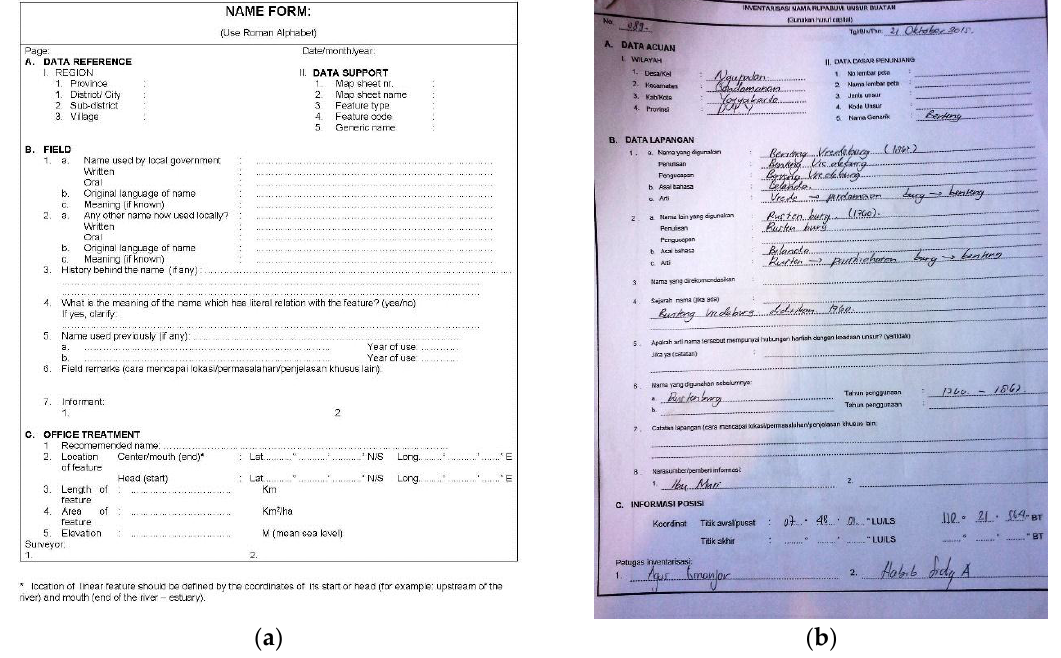
Figure 3. Names form used by the national naming authority (NNA) in Indonesia: ( a ) an example of the “Name Form” for collecting toponyms in the field; ( b ) complete name form from fieldwork in Yogyakarta. (Courtesy of Badan Informasi Geospasial).